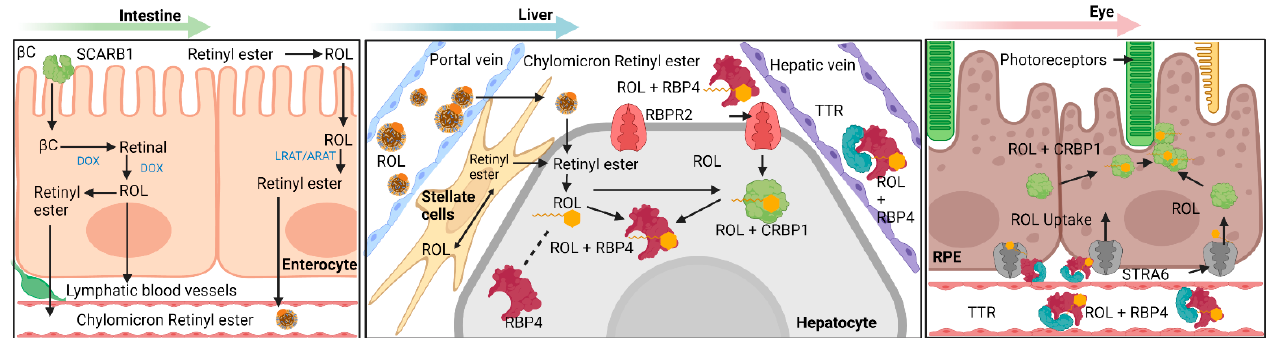
Figure 1. Overview diagram detailing the various pathways within vitamin A transport and metabolism into biologically useful forms. Generally, this process can be separated into four different categories: absorption, storage, release, and uptake. A succinct summary of these four categories is shown here for vitamin A: absorption of provitamin A into intestinal epithelial cells and initial processing into chylomicron bound retinyl esters, storage of retinyl esters within hepatic stellate cells, release of storage retinyl esters as RBP4 bound retinol into the bloodstream and uptake by the retinal pigment epithelium. Note the importance of STRA6 and RBPR2 as major facilitators in the transport of RBP4 bound retinol. β C— β -Carotene; SCARB1—Scavenger Receptor Class B, Type 1; LRAT—Lecithin Retinol Acyltransferase; ARAT—Acyl-CoA Retinol Acyltransferase (ARAT); ROL—All- Trans Retinol; STRA6 – Stimulated by Retinoic Acid 6; RBPR2—Retinol Binding Protein 4 Receptor 2; RBP4—Retinol Binding Protein 4; TTR—Transthyretin; CRBP1—Cellular Retinol Binding Protein 1; CRBP2—Cellular Retinol Binding Protein 2; RPE—Retinal Pigment Epithelium. Created with BioRender.com.